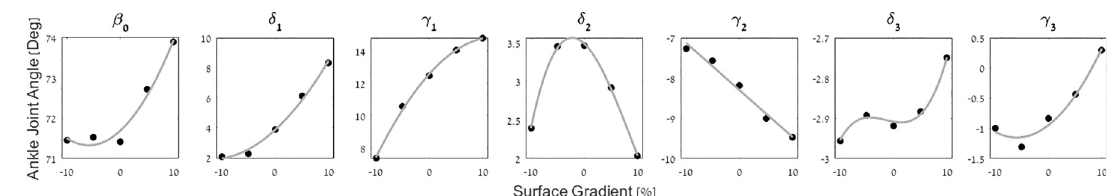
Fig 3. Stage 2: The fitted polynomial for the Fourier coefficients (black dots) as a function of surface gradient (fitted gray line) demonstrated with the ankle angle from running at 2.25 m/s.